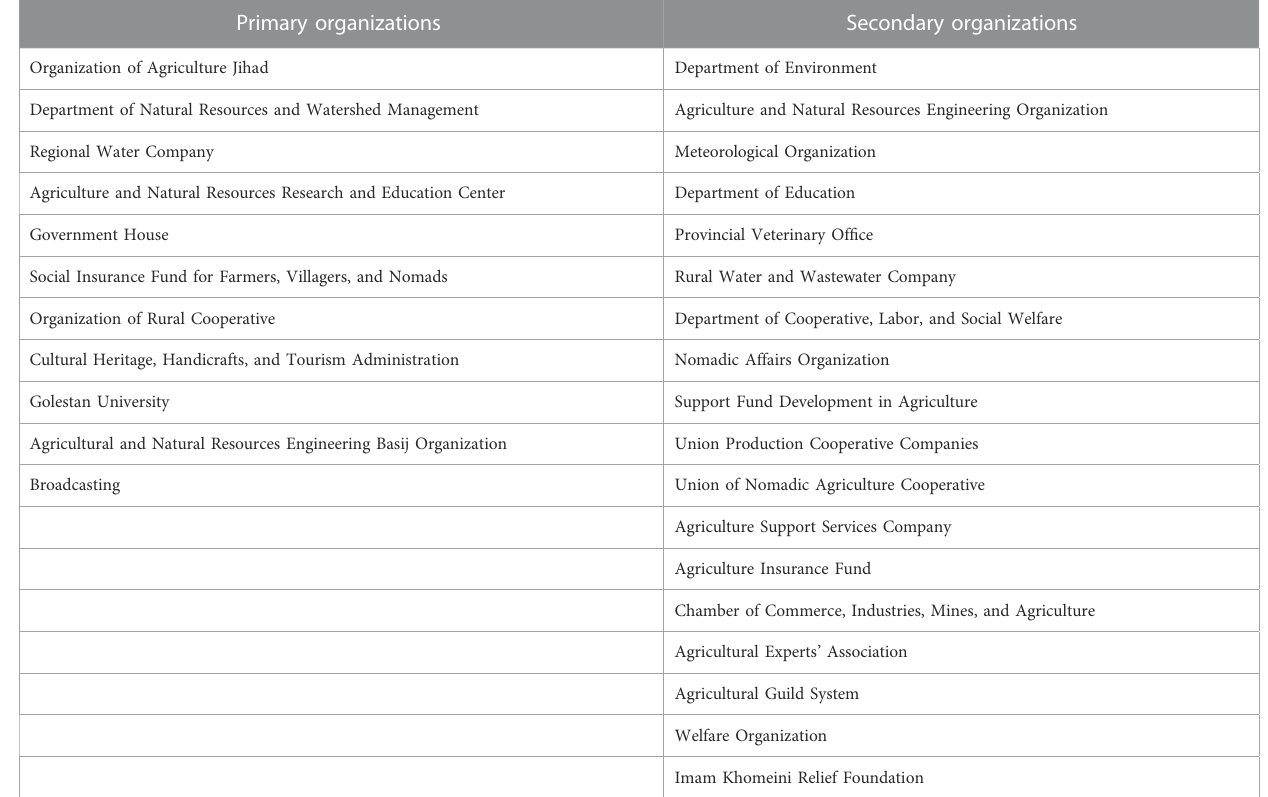
TABLE 6 Primary and secondary organizations in terms of coordination of watershed management. Primary